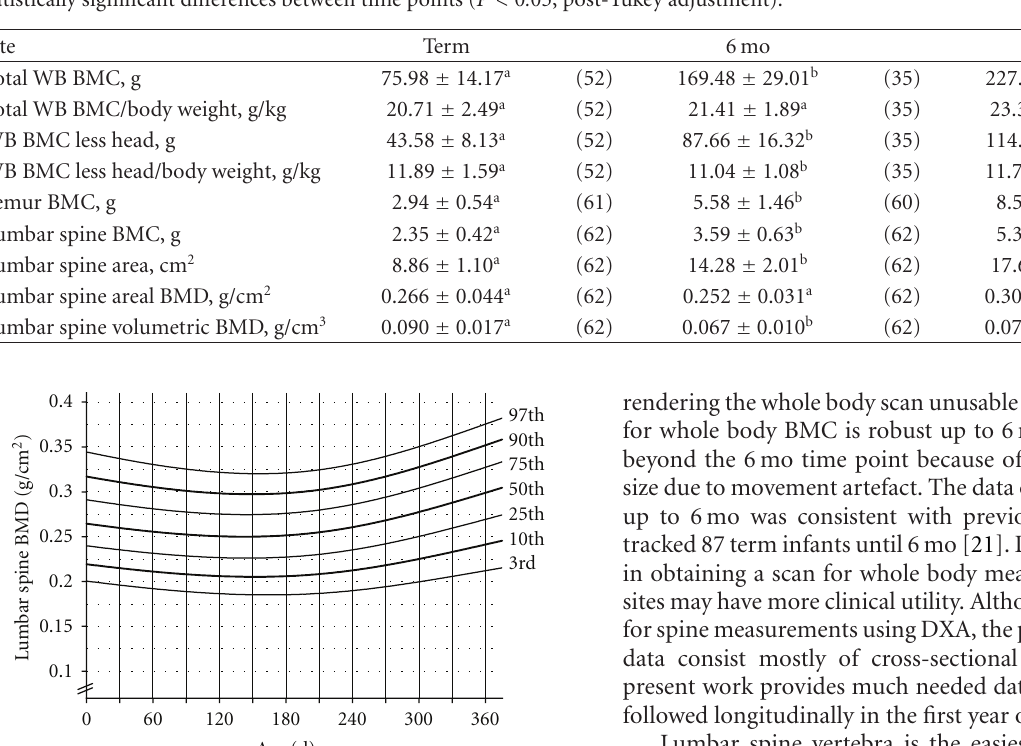
Table 3: Mean ± SD ( n ) bone mineral content of whole body, femur, lumbar spine, and bone area, areal bone mineral density, and volumetric bone mineral density of the lumbar spine from birth to 12 mo of age in term infants. Means with di ff erent superscript letters indicate statistically significant di ff erences between time points ( P < 0 . 05, post-Tukey adjustment).